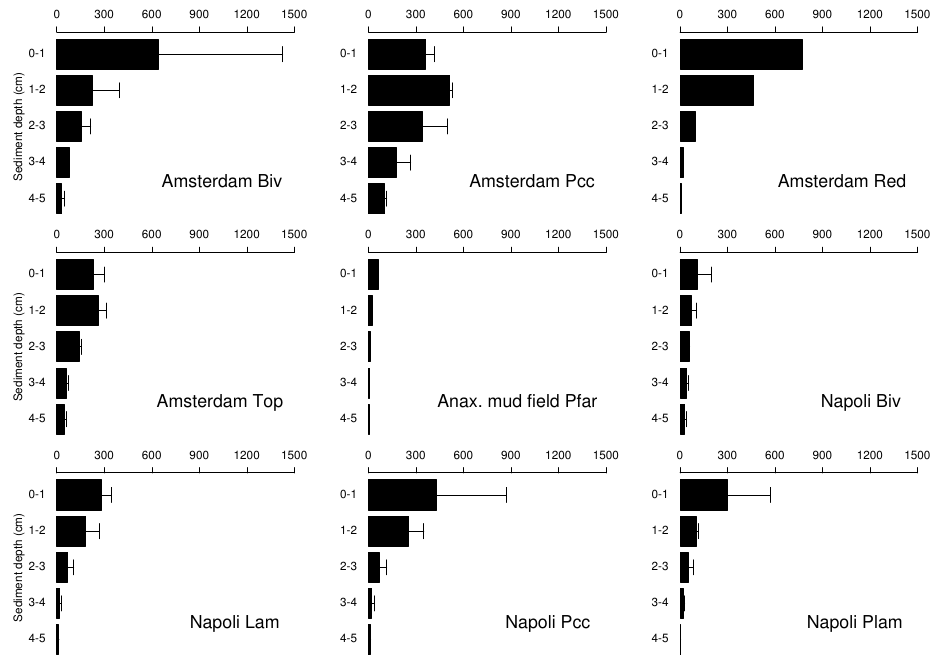
Fig. 4. Vertical distribution (individuals per 10cm 2 ) of nematodes for the different microhabitats (Biv: bivalve shells; Pcc: periphery of carbonate crusts; Red: reduced sediments; Top: summit of the mud volcano; Lam: Lamellibrachia microhabitat; Plam: periphery of Lamelli- brachia ; Pfar: far periphery). Table 3. Spearman’s correlation coefficient between environmental variables (published by Ritt et al., 2012), meiofaunal taxa, nematode species and nematode diversity (Hill’s numbers). Abbreviations: total nitrogen (TN); molar ratio (C:N); total lipids (Lipids); total car- bohydrates (CarbH); total hydrolysable amino acids (THAA); proportion of bio-available OM (Bio-av. OM); percentages of carbonates